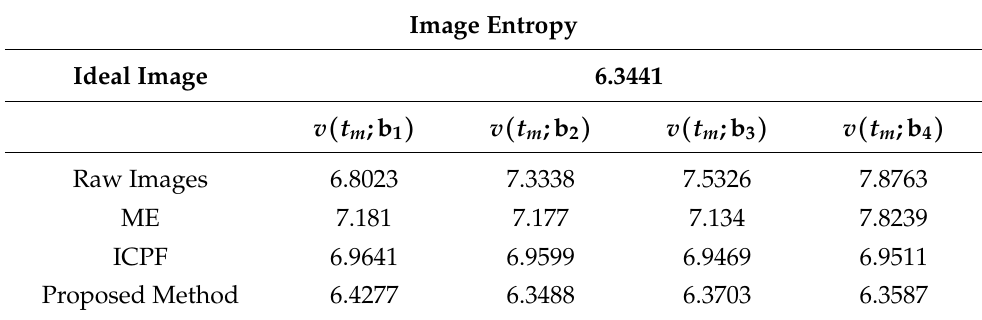
Table 5. The entropy of images acquired by different algorithms using TG-I EM simulation data.